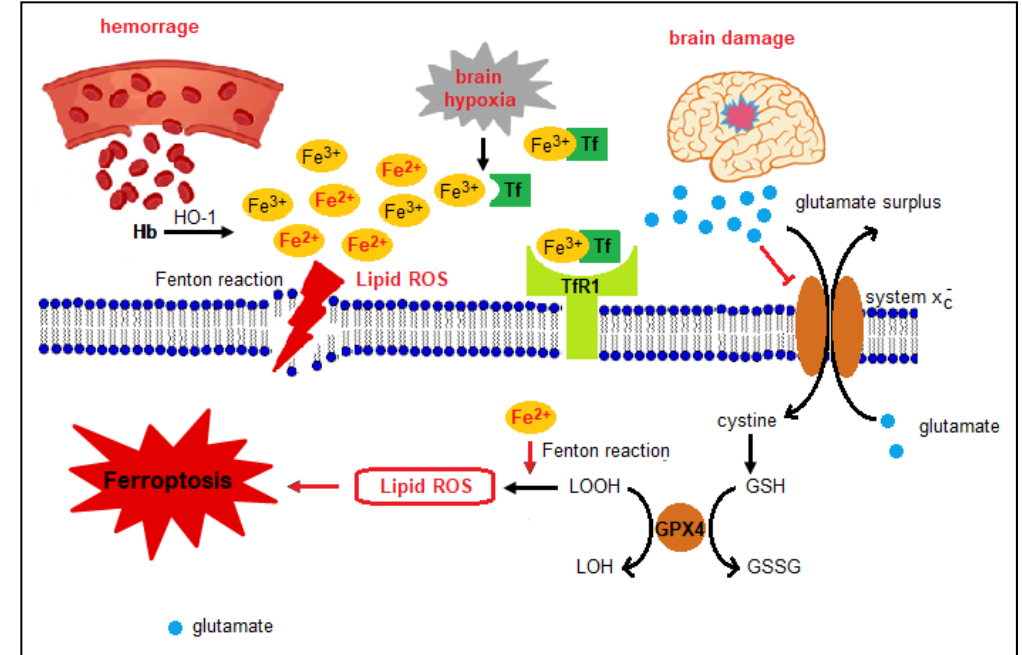
Figure 1. Presumptive molecular pathways of ferroptosis following brain injury in the developing brain. Excess free iron in the brain may be the result of Hb degradation by HO-1 after intracerebral hemorrhage. Similarly, a hypoxic-ischemic insult enhances iron liberation from its binding proteins. Fe 2 + , the reactive form of iron, promotes ROS production via the Fenton reaction leading to lipid peroxidation and membrane damage while the damaged brain releases glutamate. High extracellular glutamate concentrations inhibit the cystine / glutamate antiporter system xc- thus reducing cellular cystine levels, necessary for GSH synthesis. Reduced intracellular cystine concentration indirectly inactivates GPX4, the enzyme responsible for lipid hydroperoxide reduction and GSH consumption. The accumulation of lipid hydroperoxides in an enriched Fe 2 + environment leads to significant lipid ROS formation that induces membrane permeabilization and ferroptosis [6,47]. Fe 2 + : ferrous cation;